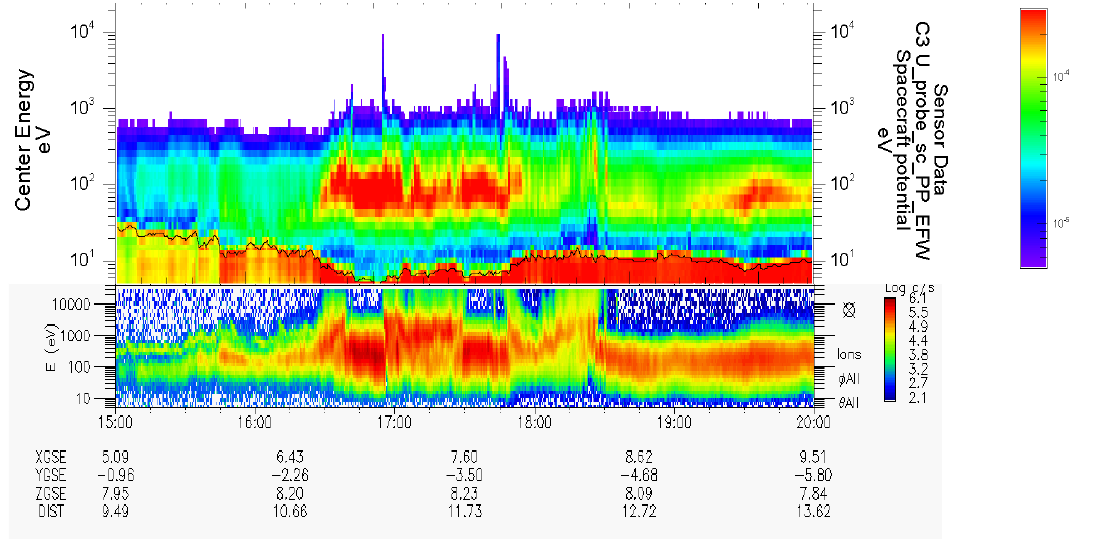
Fig. 3. The plasma data provided by PEACE and CIS instruments on Cluster SC3 during 15:00–20:00 UT on 18 April 2002. The cusp crossing occurred during 16:25–17:55